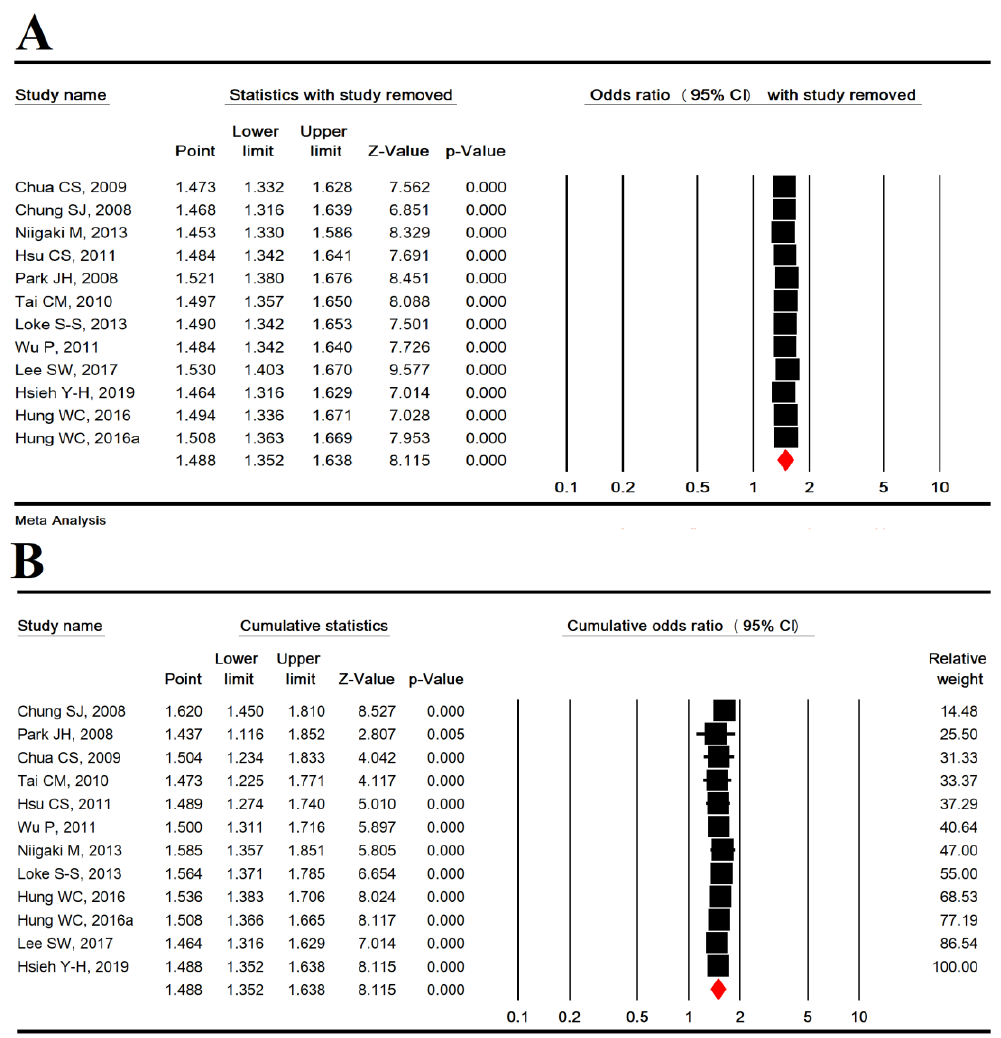
Figure 2: The association between metabolic syndrome and increased risk of erosive esophagitis